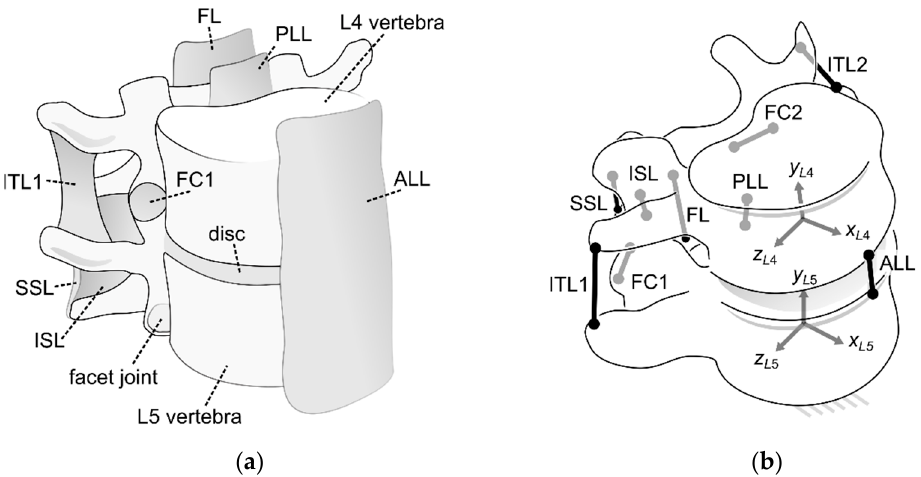
Figure 1. ( a ) The L4–L5 intervertebral joint (IJ); ( b ) the ligament system of the IJ (ligaments substituted with cables).